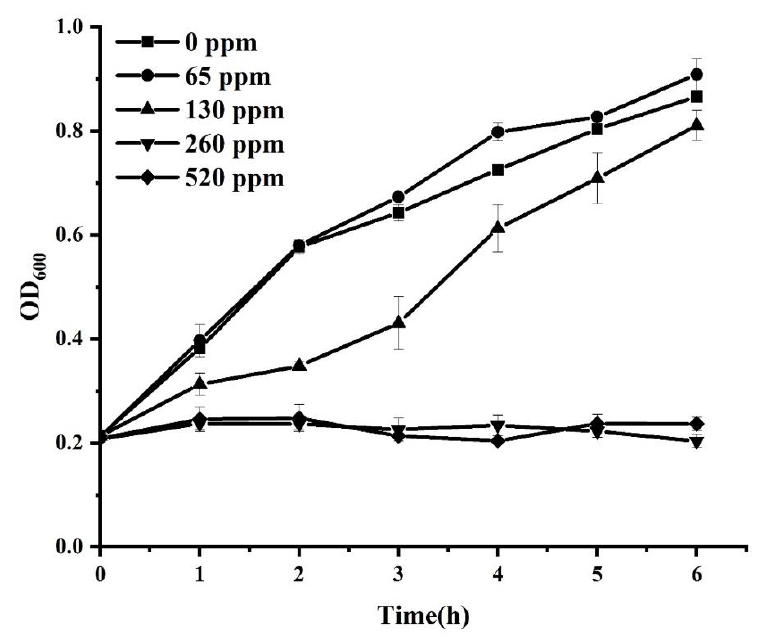
Figure 1. Growth curve of S . Enteritidis in different concentrations of sodium hypochlorite.